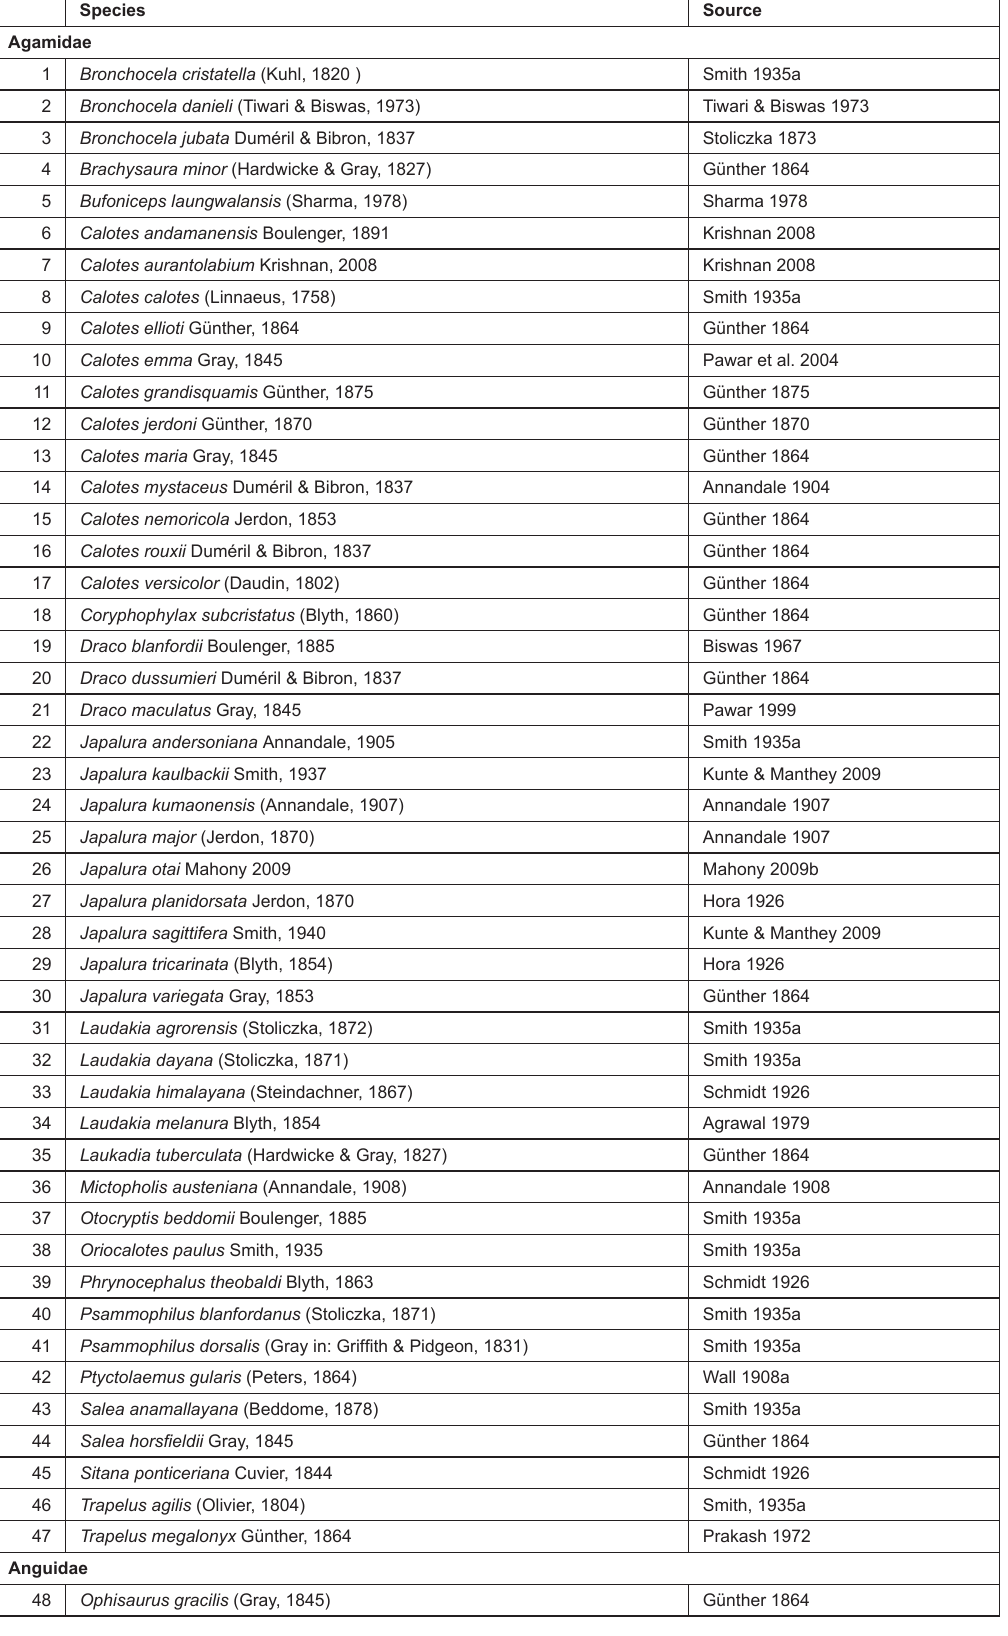
Table 1. List of Saurid reptilian species with valid distributional records within India (Category A). Species Source